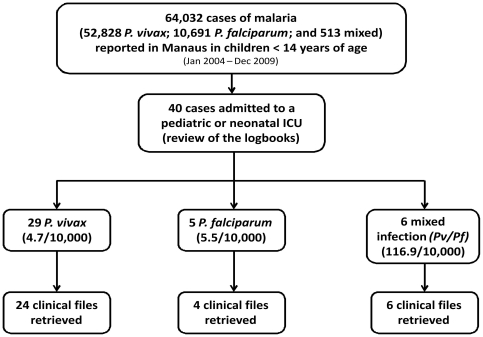
Flow diagram of patients admitted to ICUs enrolled in the analysis.